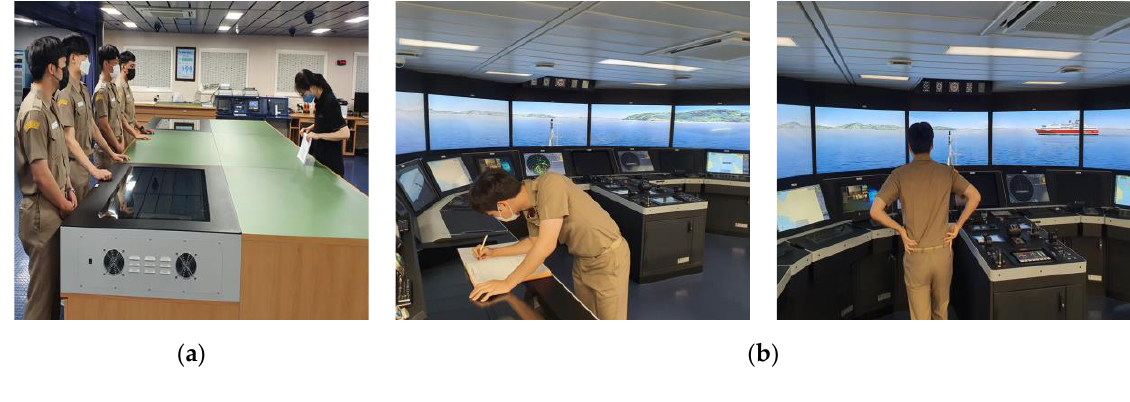
Figure 4. Experiment